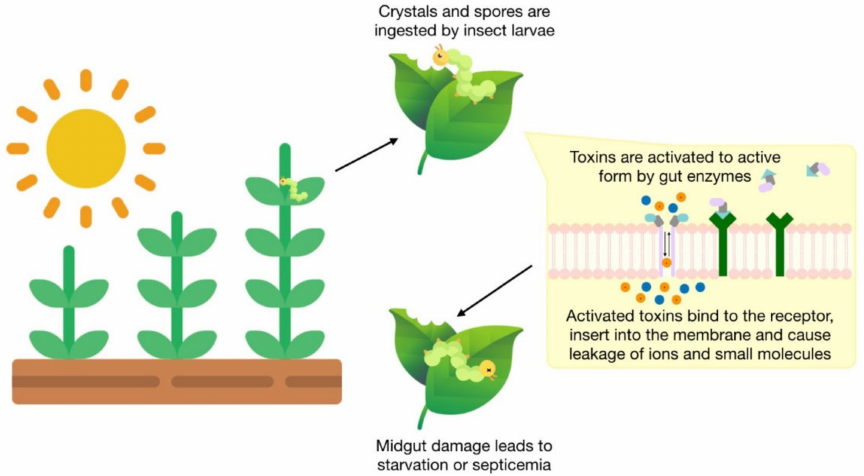
Figure 6. Mechanism of action of Bacillus thuringiensis toxin. Icons made by Freepik and Smashicons from www.flaticon.com (accessed on 1 December 2021). Adapted from